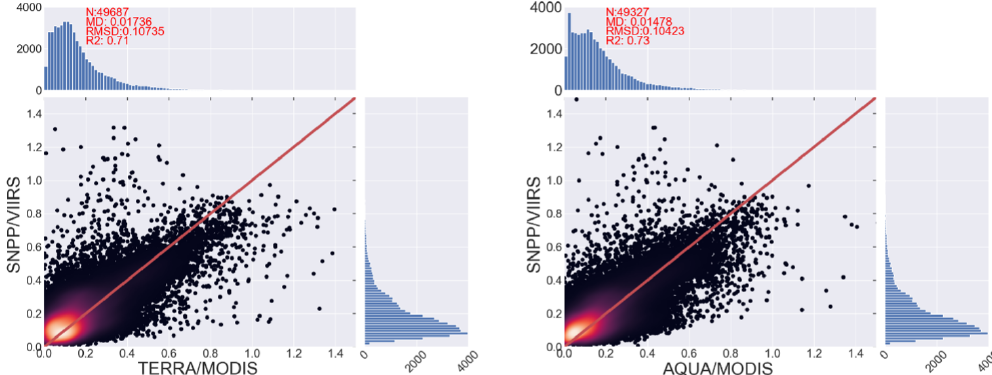
Figure B6. SNPP/VIIRS vs. MODIS AOD scatter plots of temporal mean AOD over land for the DJF period.